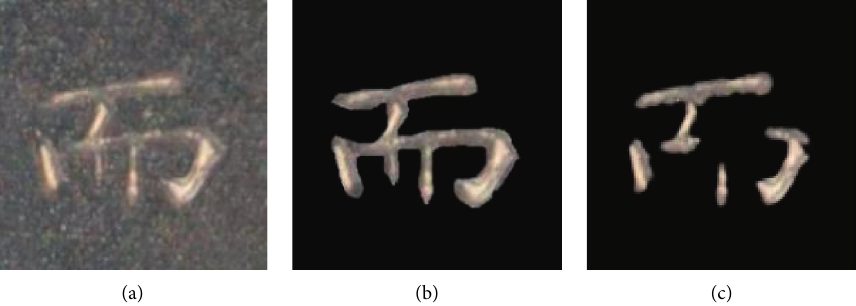
Figure 5: The problem of image denoising. (a) The original image. (b) Ground truth. (c) The denoising result image.